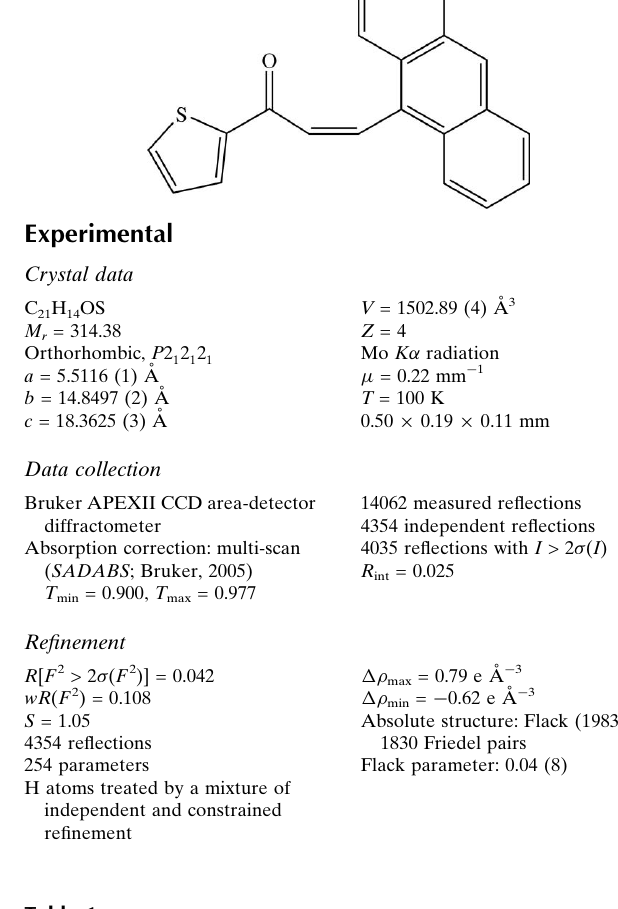
Bruker APEXII CCD area-detector diffractometer